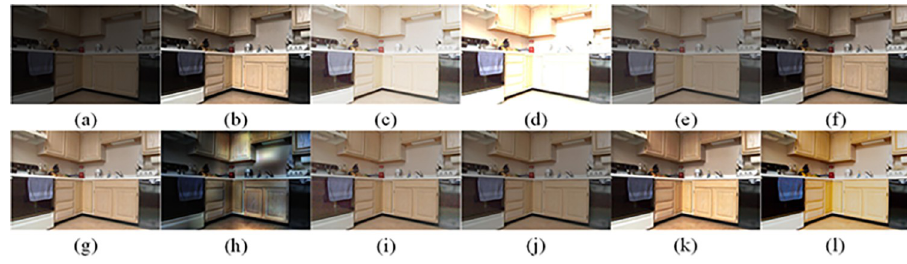
Fig 30. Comparisons of the ten algorithms in enhancing low-light image 20. (a) low-light image (b) AGCWD (c) Al-Ameen (d) BHE2PL (e) BIMEF (f) BPDHE (g) LIME (h) MSRCR (i) NPEA (j) SRIE (k) OURS (l) Normal light